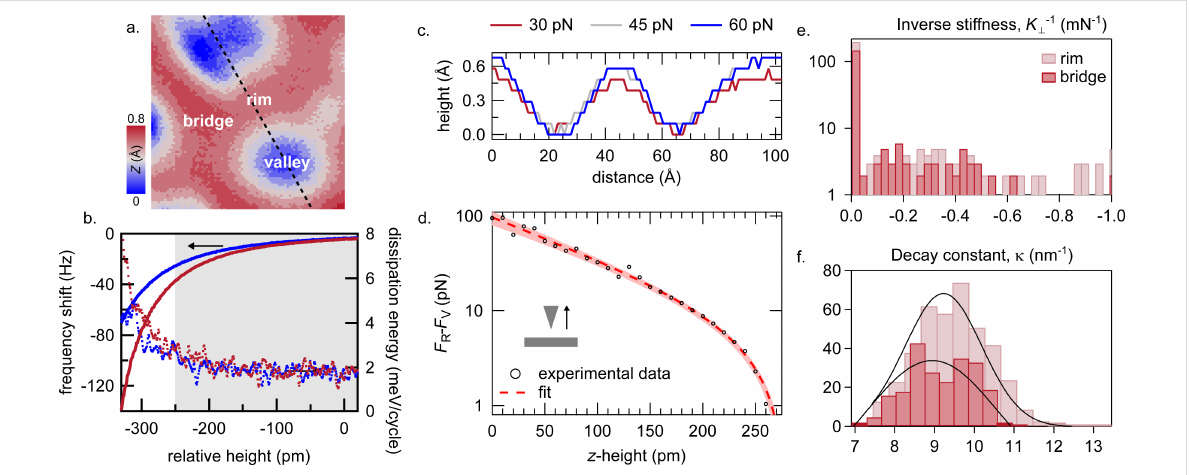
Figure 4: Local stiffness of h -BN/Cu(111). (a.) Topography of an 8 × 8 nm 2 h -BN/Cu(111) area corresponding to a constant force F ⟂ = 30 pN. (b.) Point Δ f and excitation energy vs relative z -height curve obtained at rim (red) and valley (blue) positions. The grey shaded area marks the z -range used for the Δ f maps. (c.) Line profiles taken from constant-vertical-force maps along the black dashed line in (a.), at F ⟂ = 30 pN (red), 45 pN (grey), and 60 pN (blue), respectively. (d.) Average attractive short-range force obtained for the rim and the bridge region after subtracting the contribution from valley area (experimental data) and fit. The red area marks the 90% confidence range. (e., f.) Histograms of inverse stiffness ( ) and decay constant ( κ ) of the rim (pink) and bridge sites (red),